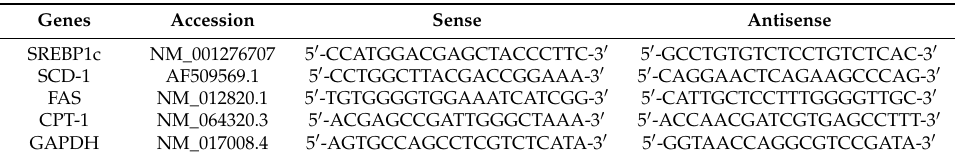
Table 1. The sequences of primers for